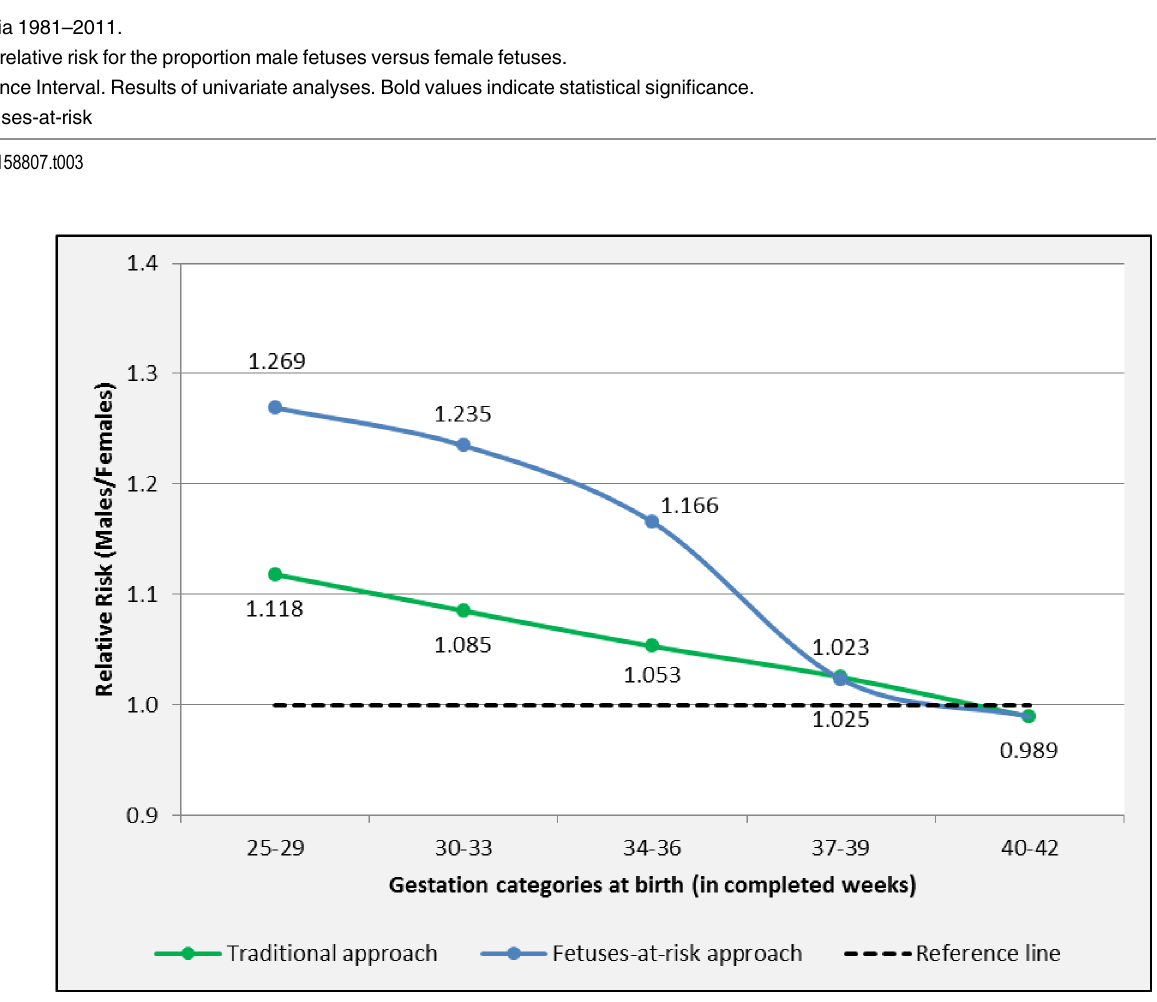
Fig 3. Sexual dimorphism for spontaneous birth by length of gestation. Births in South Australia 1981 – 2011. Marked points represent significant RR